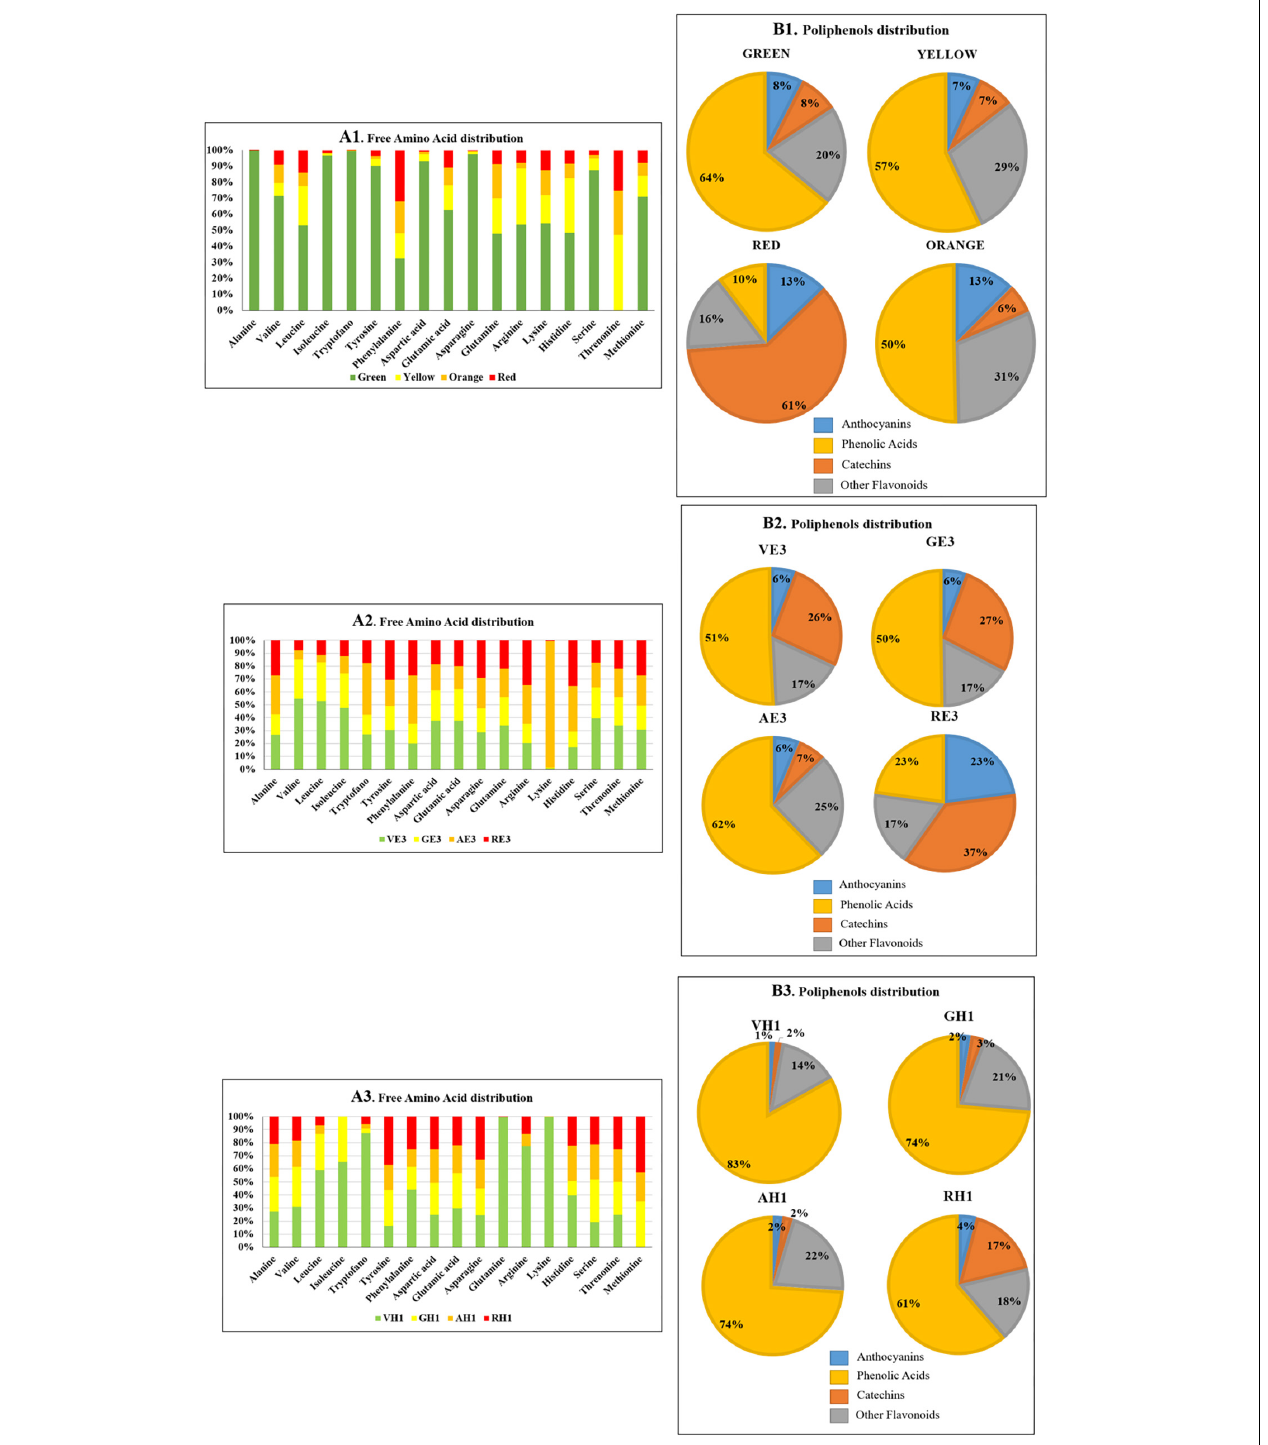
FIGURE 6 | Summary of MRM/MS E7, E3, and H1 analysis of butanol extracts of A. unedo fruit samples in different ripening stages (green, yellow, orange, and red) (A1) free amino acid distribution. (B1) Pie charts pointing the percentage composition of A. unedo polyphenolic fraction extracted with the mixture E7. Four different compound classes were grouped: anthocyanins, phenolic acids, catechins, and other flavonoids. (A2) free amino acid distribution. (B2) Pie charts pointing the percentage composition of A. unedo polyphenolic fraction extracted with the mixture E3. A total of four different compound classes were grouped: anthocyanins, phenolic acids, catechins, and other flavonoids. (A3) Free amino acid distribution. (B3) Pie charts pointing the percentage composition of A. unedo polyphenolic fraction extracted with the mixture H1. A total of four different compound classes were grouped: anthocyanins, phenolic acids, catechins, and other flavonoids.